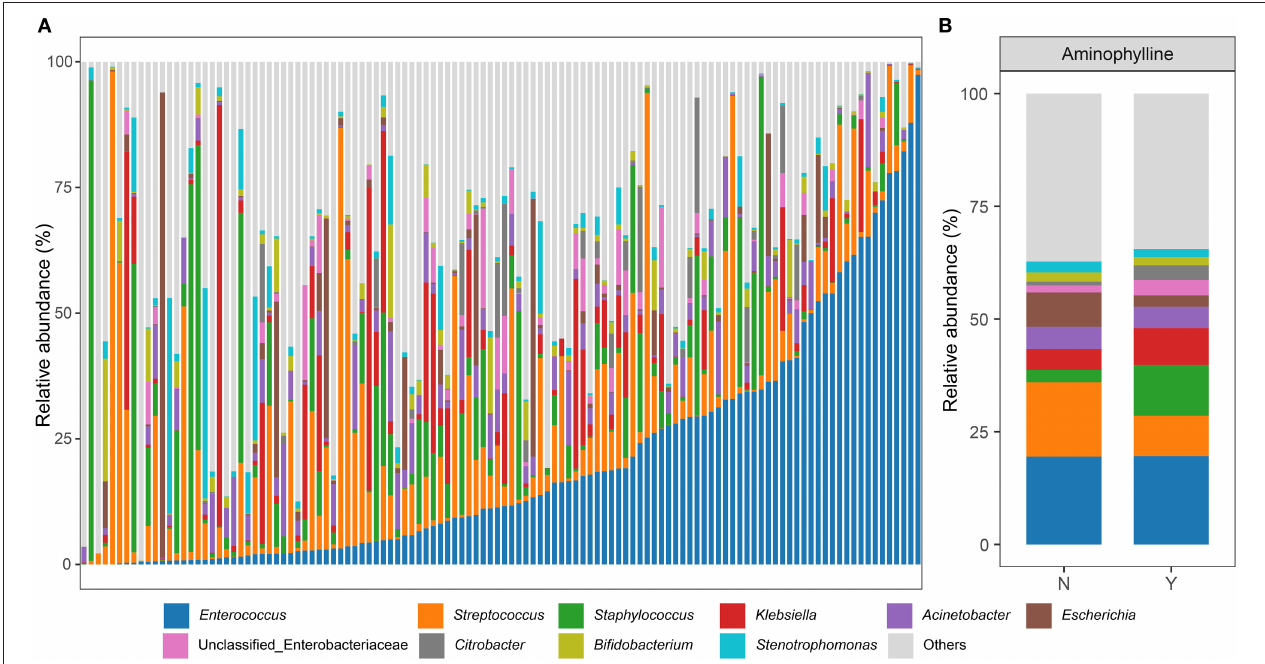
FIGURE 3 | Genus-level microbiome composition in patients. (A) Relative abundances of the top 10 abundant genera are displayed. Each bar represents the mean abundance of all samples of a patient. (B) The relative abundances at the genus level between patients who received aminophylline and those who did